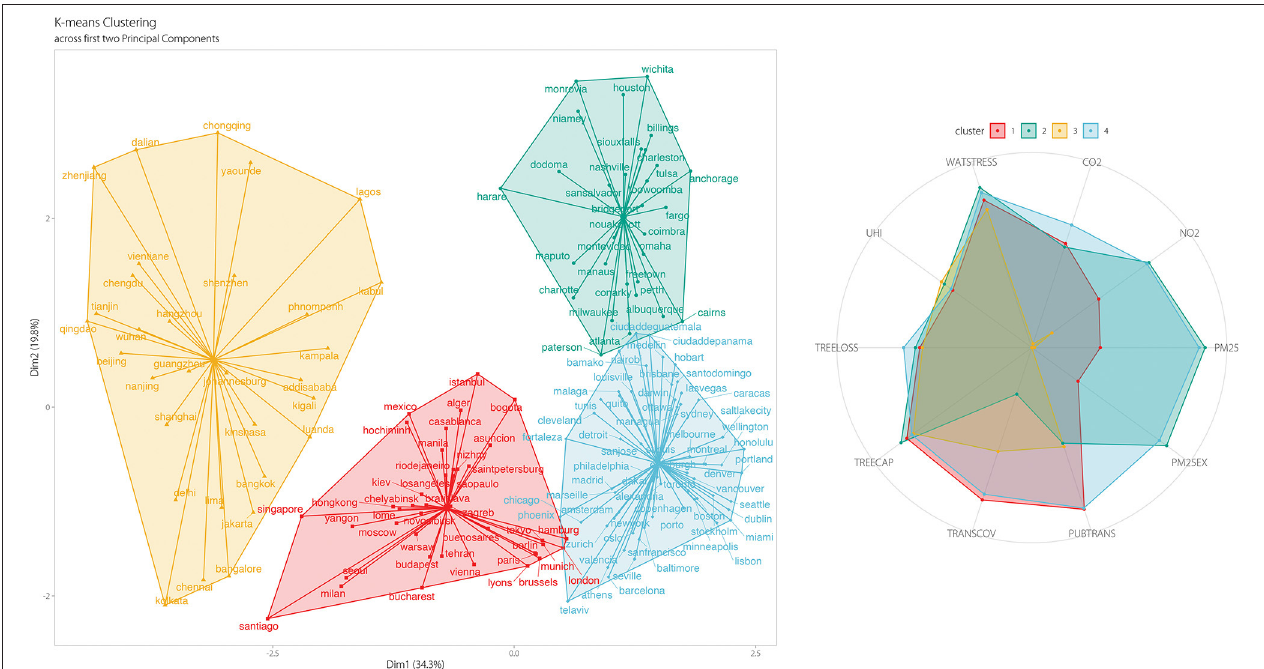
FIGURE 6 | Typologies of urban environmental performance for the cities evaluated in the